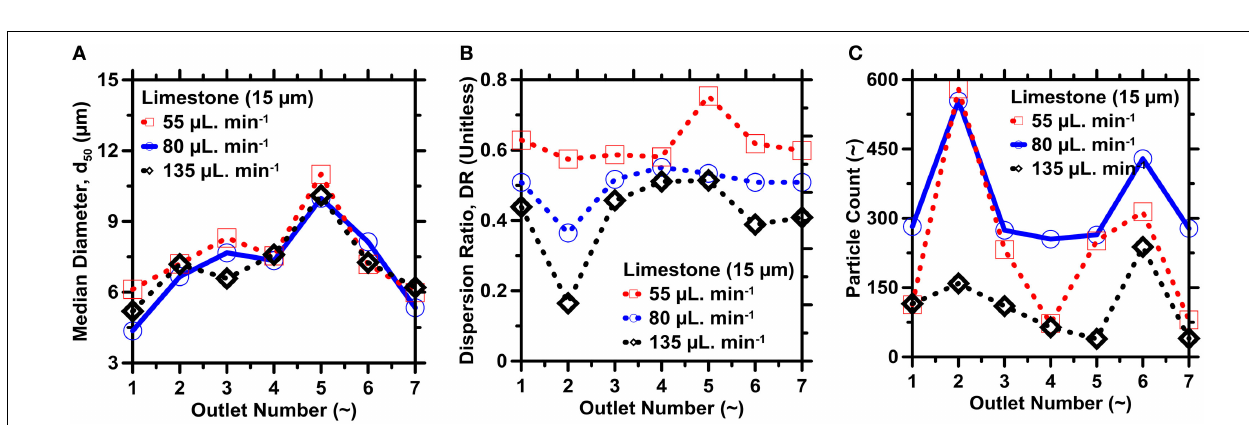
FIGURE 12 | (A) Median particle diameter, (B) dispersion ratio, and (C) particle yield of limestone in different outlets for different flow rates. The highest uncertainty in d 50 , DR, and the particle yield as determined from ICA on replicate images are on the order of 5, 7, and 9%, respectively.